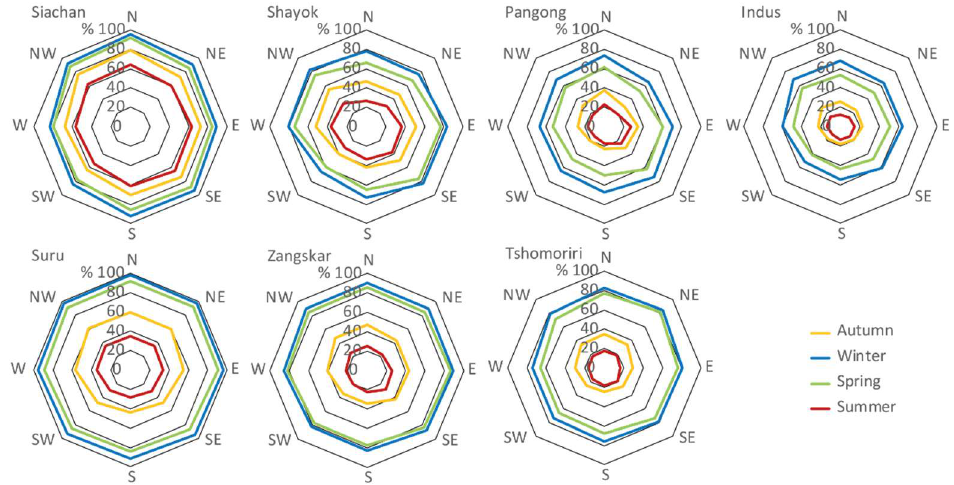
Figure 11. Seasonal MODIS SCA in relation to aspect across all subregions of the study area over the observation period of 2000–2019.